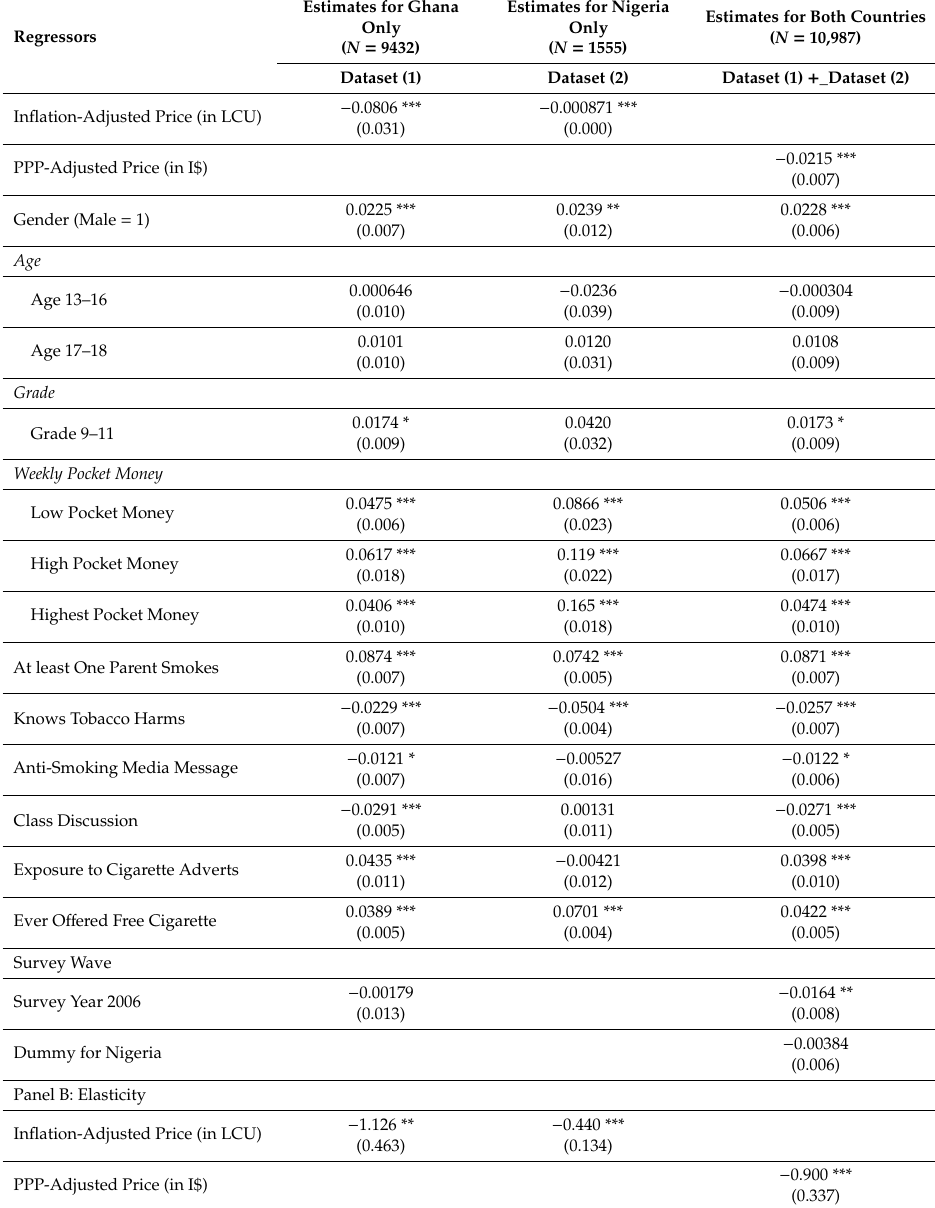
Table 2. Logit models of a 30-day cigarette smoking among youth (aged 11–18) in Ghana and Nigeria (standard errors in